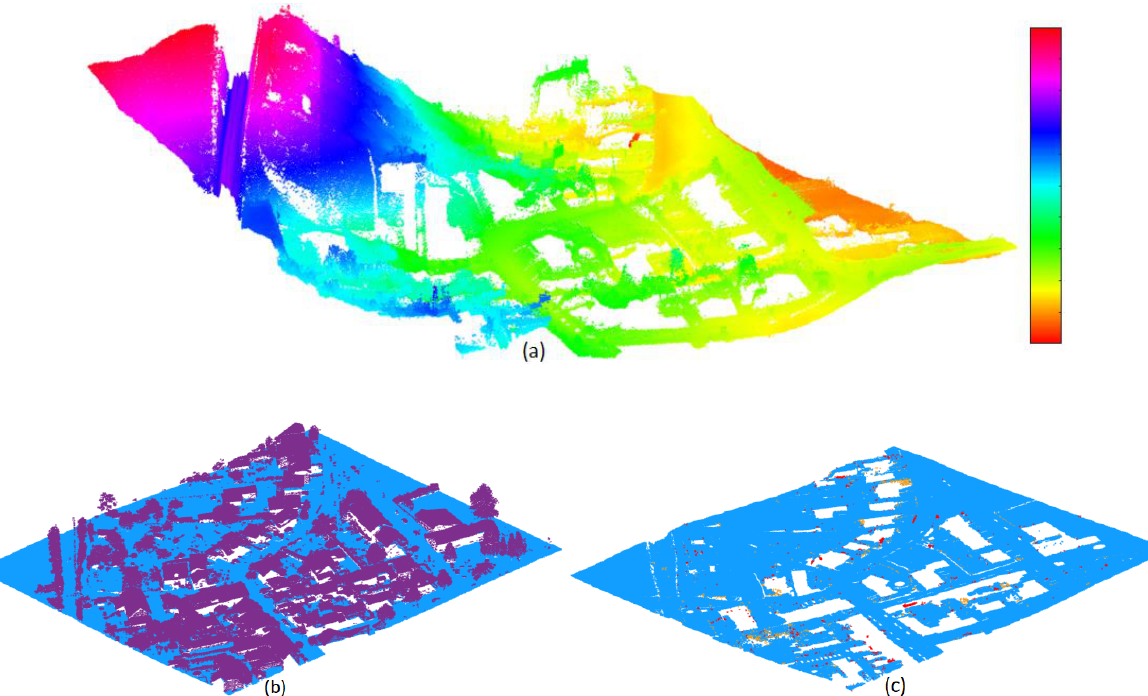
Figure 4. Results for ACT data; (a) Presence of height discontinuity in the terrain, (b) classified ground (blue) and non-ground points (purple), (c) false positives (yellow) and false negatives (red) cases.